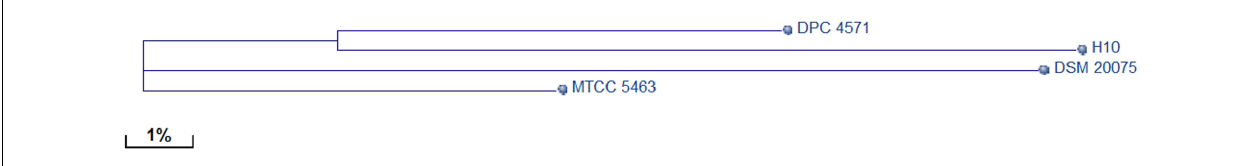
FIGURE 1 | Dendogram of L. helveticus strains sequenced to completion (DPC 4571, DSM 20075, H10, and MTCC 5463) based on genomic